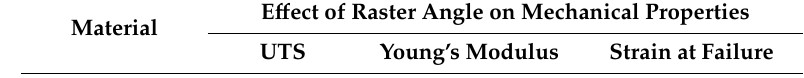
Table 3. Results of one-way ANOVA comparing raster angles on mechanical properties of PLA and PETG.